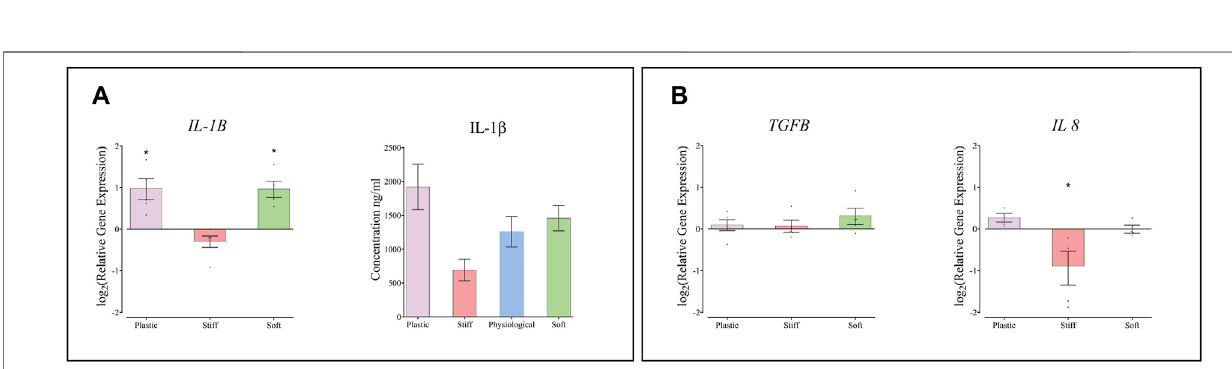
Frontiers in Bioengineering and Biotechnology |